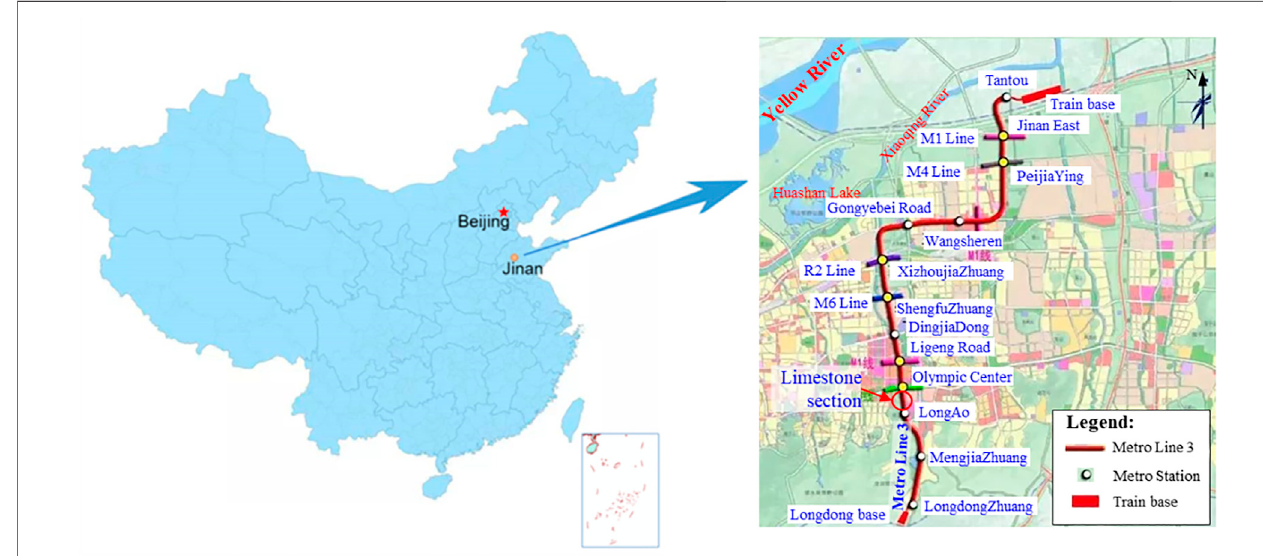
FIGURE 1 | Location map of Jinan R3 metro